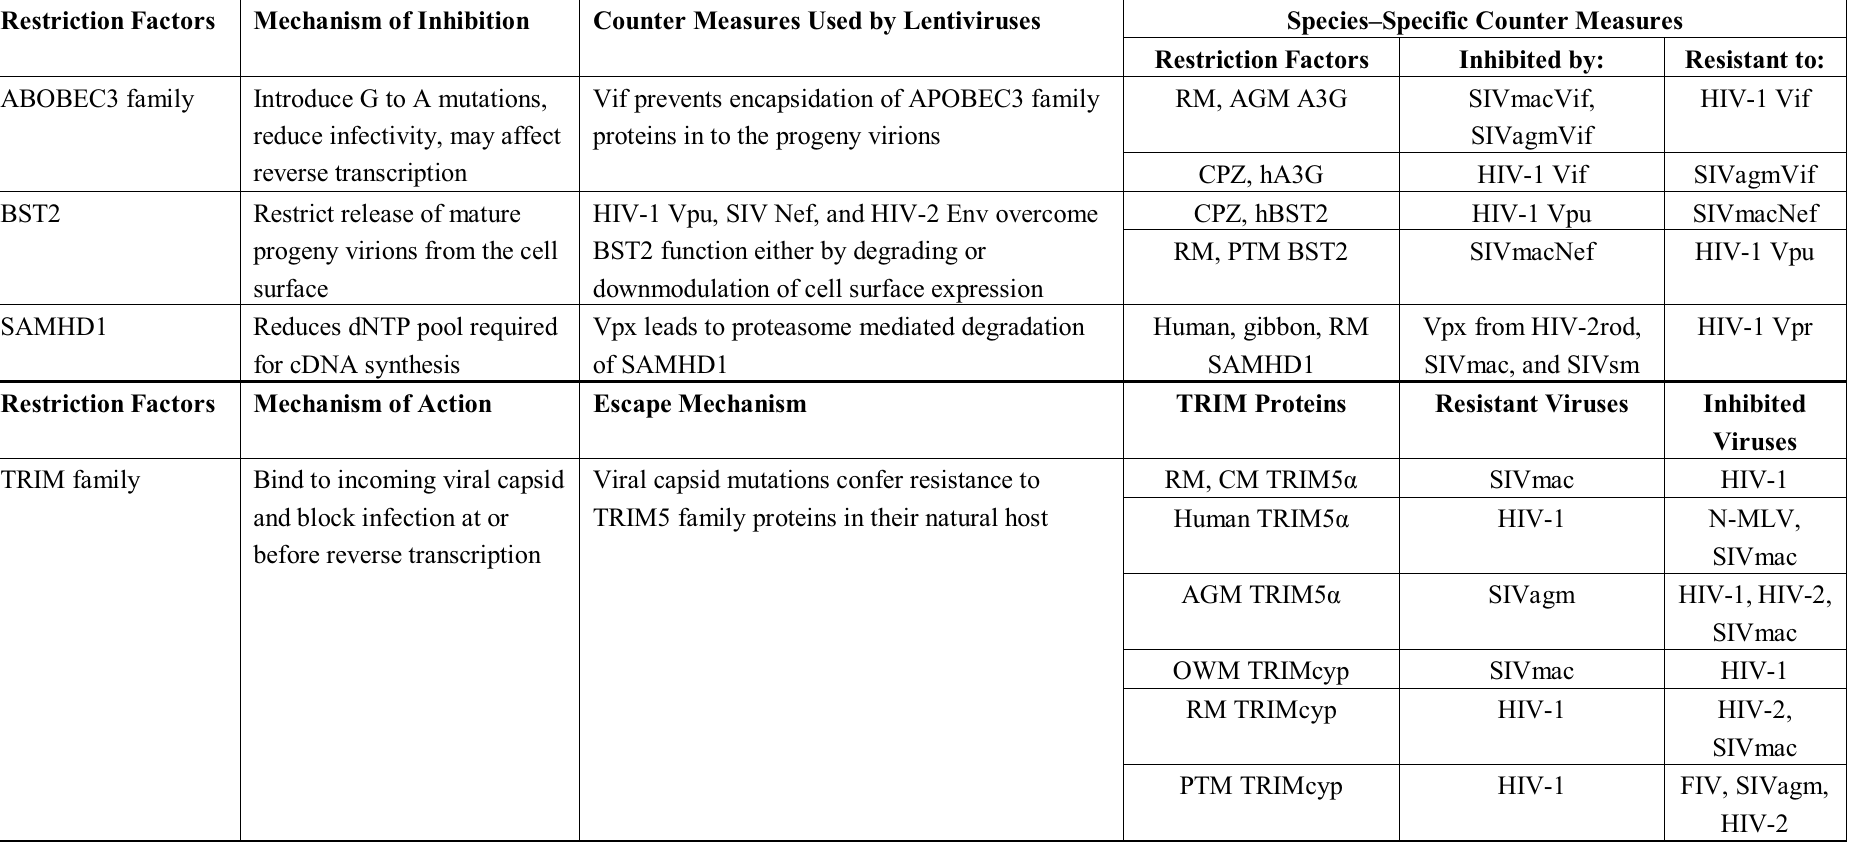
Table 1. Restriction factors and the counter